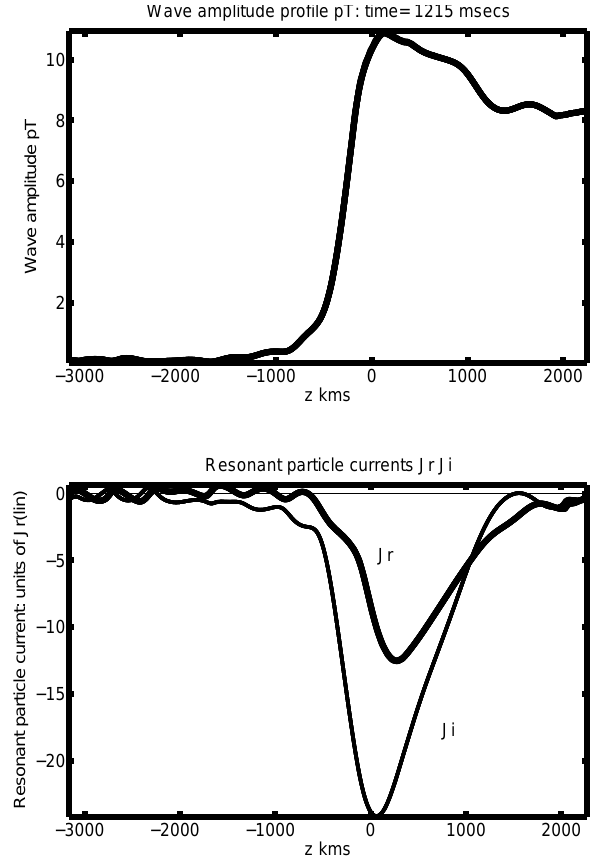
Fig. 8. Run 1. Snapshot at t = 1 . 215s of wave amplitude, the in phase current J r , and out of phase current J I as functions of z . Note the characteristic structure of a dynamically stable riser generation region.